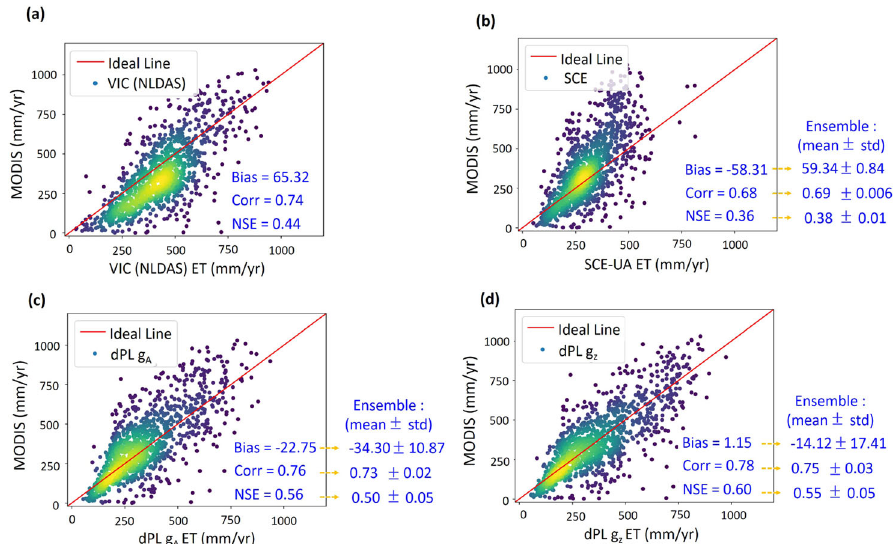
Fig. 4 Uncalibrated variable (evapotranspiration, ET) metrics from models trained at 1/8 2 sampling density. Scatter plots of temporal-mean ET (mm/ year) comparing the MOD16A2 satellite product with ET produced by a NLDAS-2, b SCE-UA, and dPL options c g A , and d g Z . Each point on the scatter plot is the temporal mean ET of a 1/8-latitude-longitude-degree gridcell de fi ned on the NLDAS-2 model grid. Yellow color indicates higher density of points. The ensemble metrics are from training the model with different random seeds, while the 1-vs-1 plots came from one particular random realization. Panel a is for the NLDAS-2 ’ s default VIC model simulation and does not have an ensemble.